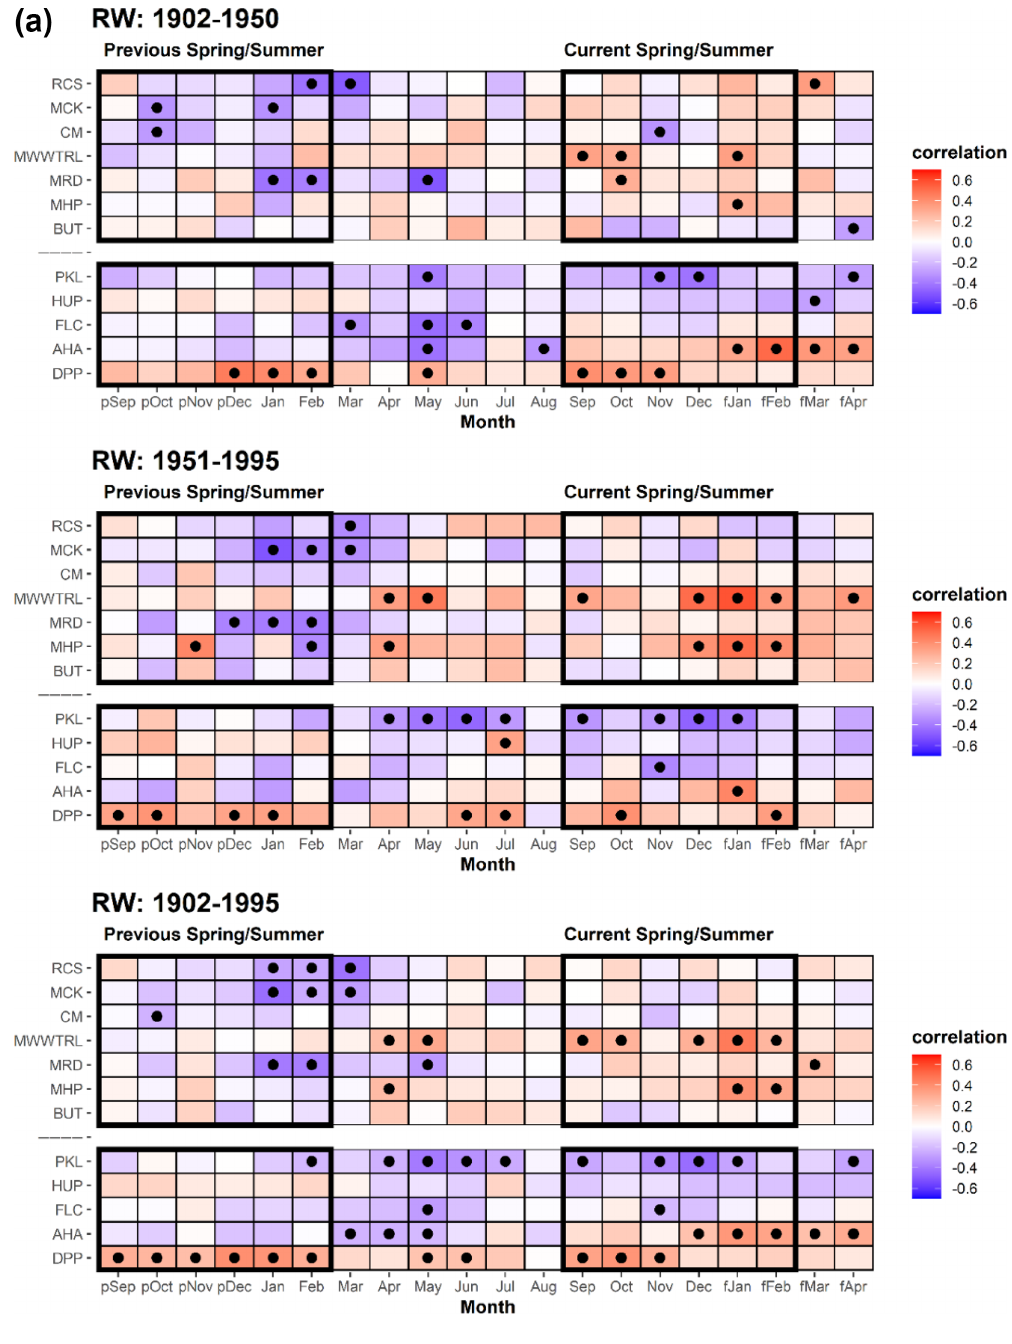
Table A3. (a) Correlation response function analysis for ring width with CRUTS temperatures. Analysis was undertaken over the 1902–1950, 1951–1995, and 1902–1995 periods. Black dots denote correlations significant at the 95% confidence limit. (b) As 3a but for EWB. (c) As 3a but for LWB. (d) As 3a but for